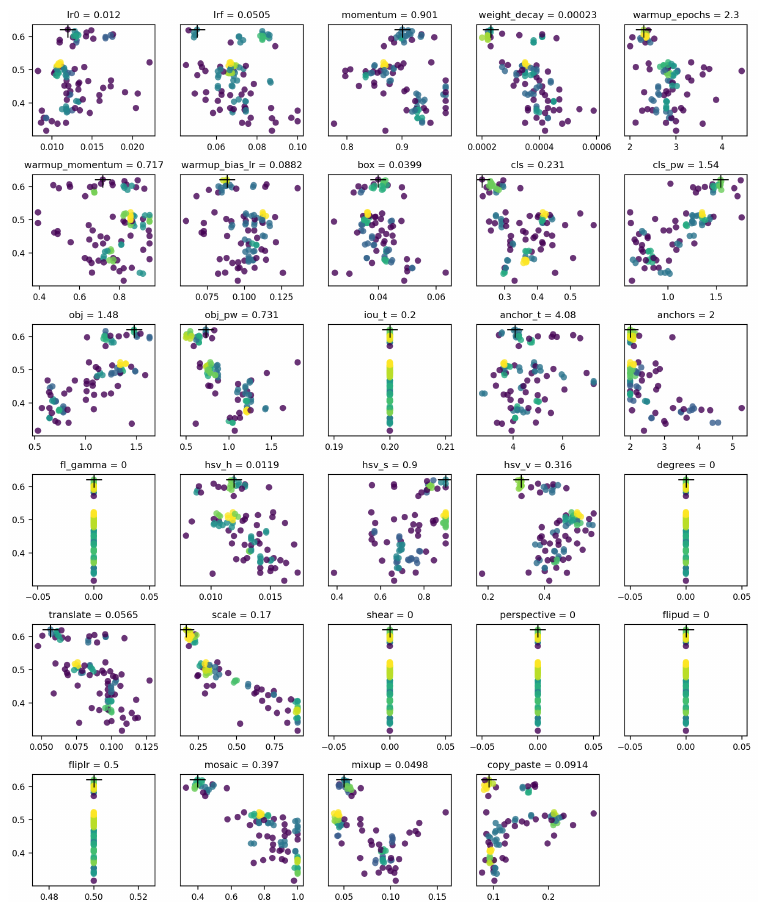
Figure 15. Hyperparameter evolution process and final hyperparameter